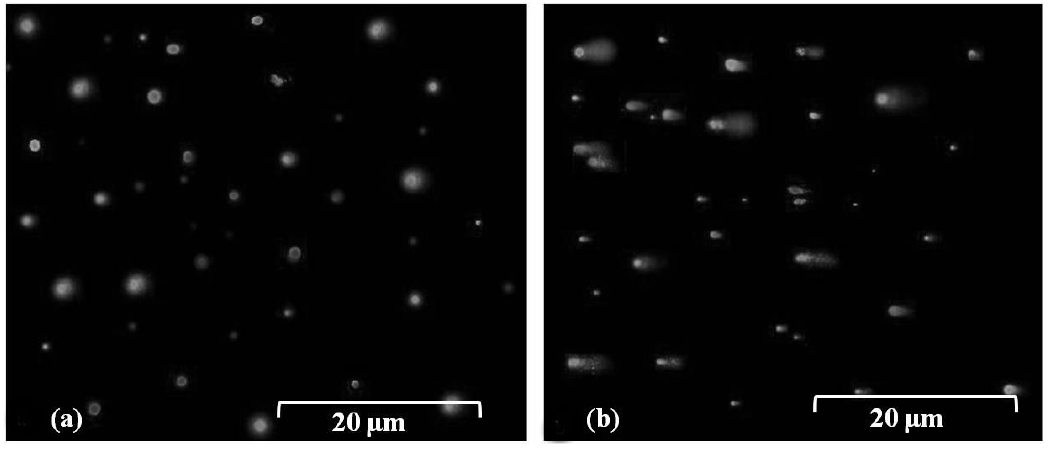
Figure 3. SGCE assay for the DNA damage of bacterial cells after 30 s exposure of B. glumae strains to ( a ) PVC control surfaces. ( b ) Dry metallic copper surfaces. Bar = 20 μ